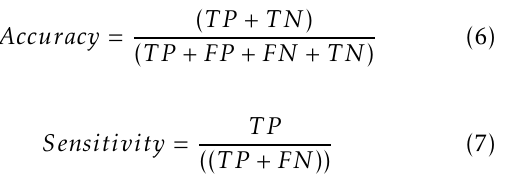
number: 10.17632/snkd93bnjr.1. The dataset contains 17,092 images :lymphocytes (1214), neutrophils (3329), basophils (1218), monocytes (1420), eosinophils (3117), immature granulocytes (2895), erythroblasts (1551) and platelets (2348). An example of the eight components is presented in figure